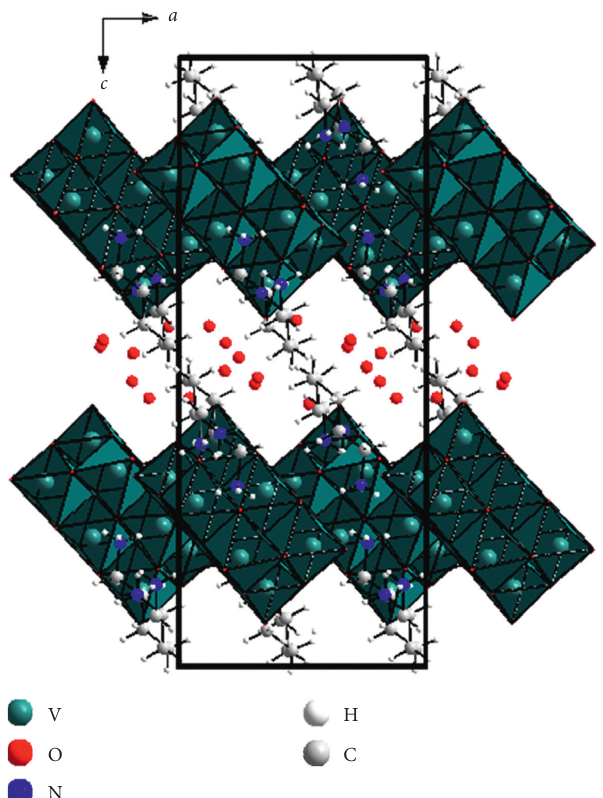
Figure 3: Projection of the (C